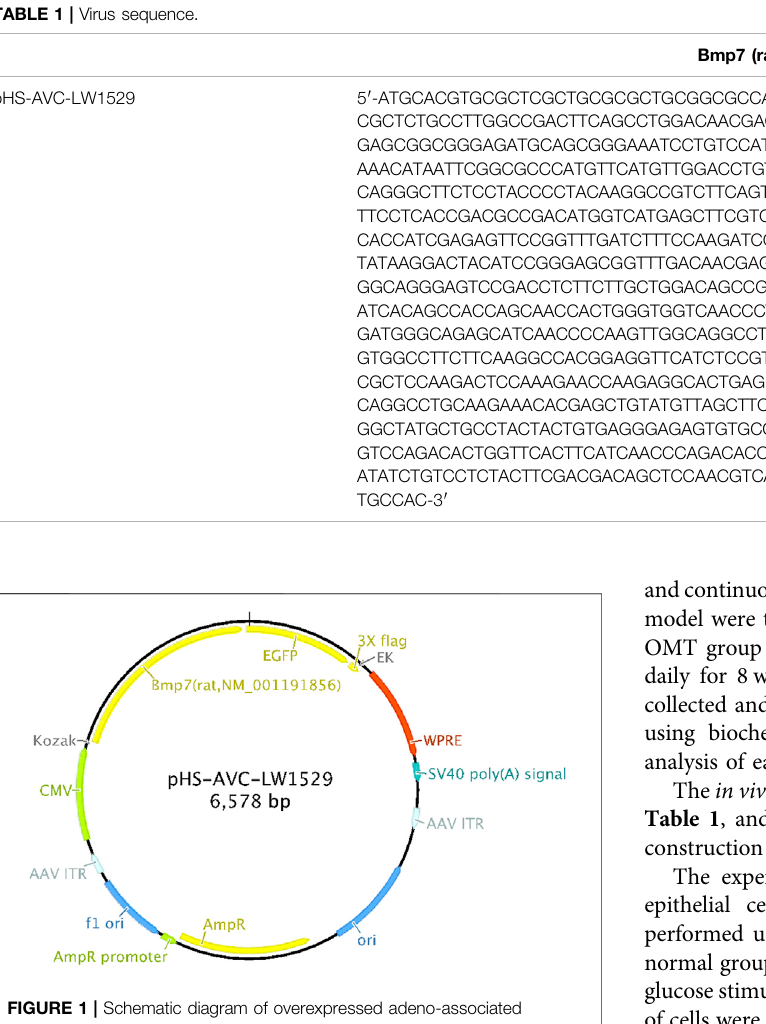
FIGURE 1 | Schematic diagram of overexpressed adeno-associated virus